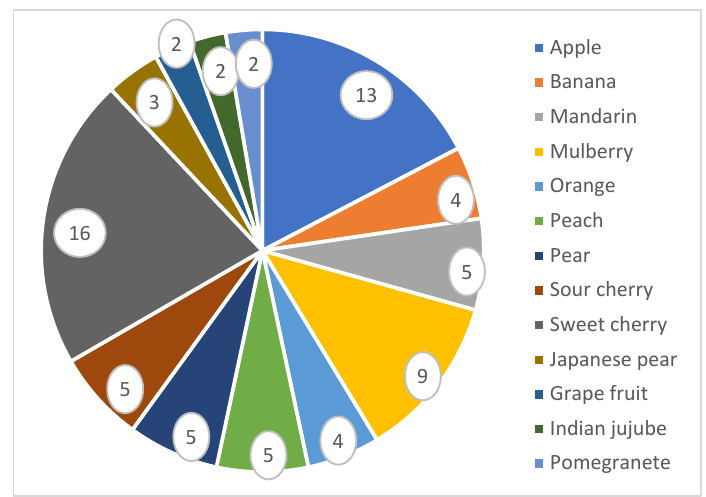
Figure 4. Development of mutant varieties in different fruit species